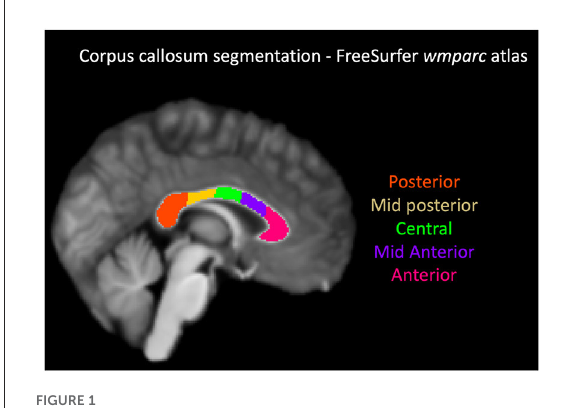
FIGURE1 Corpus callosum segmentation with FreeSurfer wmparc atlas. From the anterior to posterior aspect, the segments were labeled and color coded as follows: anterior-magenta, mid anterior-purple, central-green, mid posterior-yellow,